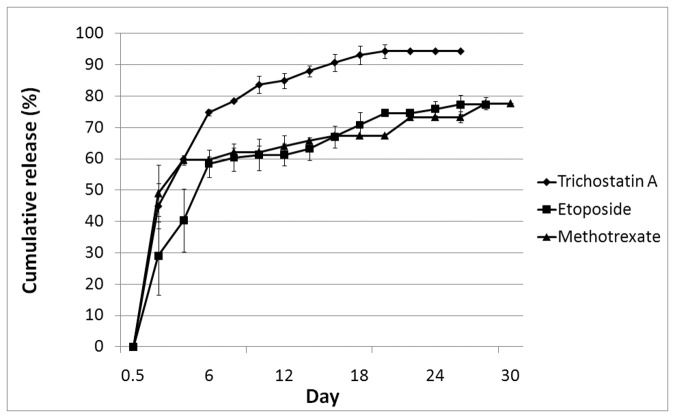

In
vitro cumulative release profiles of agents loaded onto PLGA/PEG matrices.All drug release behaviors from the drug-loaded polymer matrices were investigated under simulated physiological conditions (PBS, pH 7.4) at 37°C. (Top) TSA exhibits an initial burst of 44% of total drug loaded with a total of 94% of drug released by day 18 and no drug detected thereafter. (Middle) ETOP exhibits an initial burst of 29% of total drug loaded with 77% of drug released by day 26. (Bottom) MTX exhibits an initial burst of 49% of total drug loaded with 78% of drug released by day 28. No drug release is detected thereafter. Three independent matrices were used for each experimental set-up with 50µg of drug loaded per matrix. Day 0 initial burst readings were taken 4h after drug-loaded matrices were placed in PBS. UV absorbance wavelengths were as follows: TSA, 342nm; ETOP, 295nm; MTX, 324nm. Error bars represent standard error of the mean from three independent matrices.